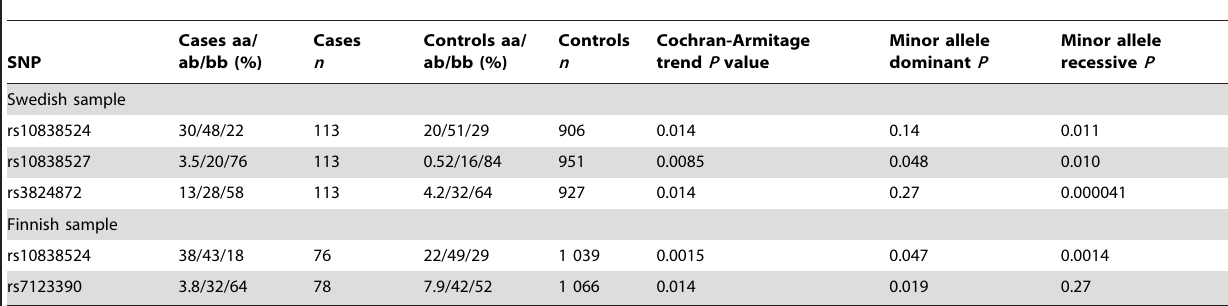
Table 2. Genotype association analysis of the SNPs with suggestive allele frequency